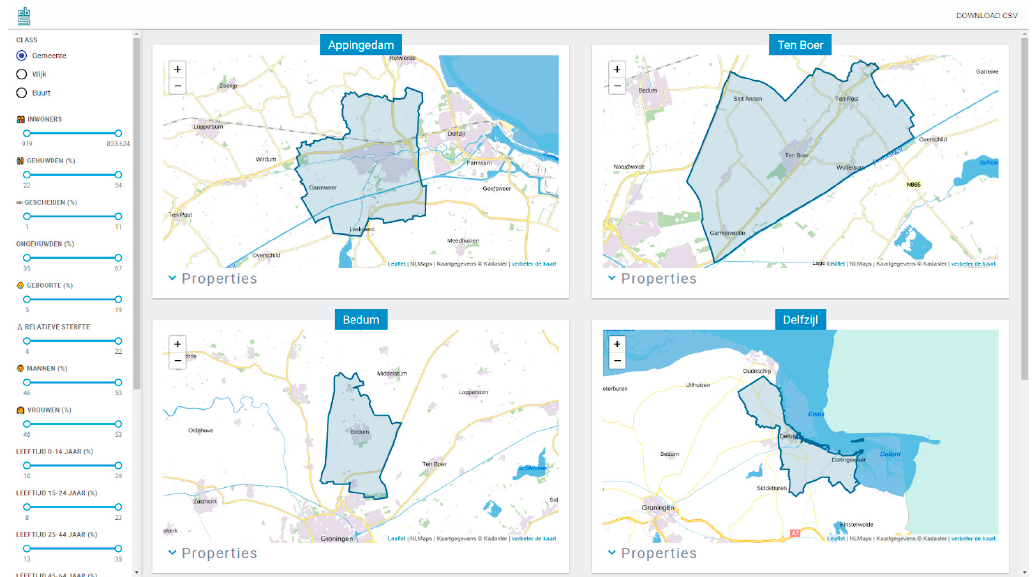
Figure 5. The prototype of FacetCheck which supports visual exploration of Linked Data.